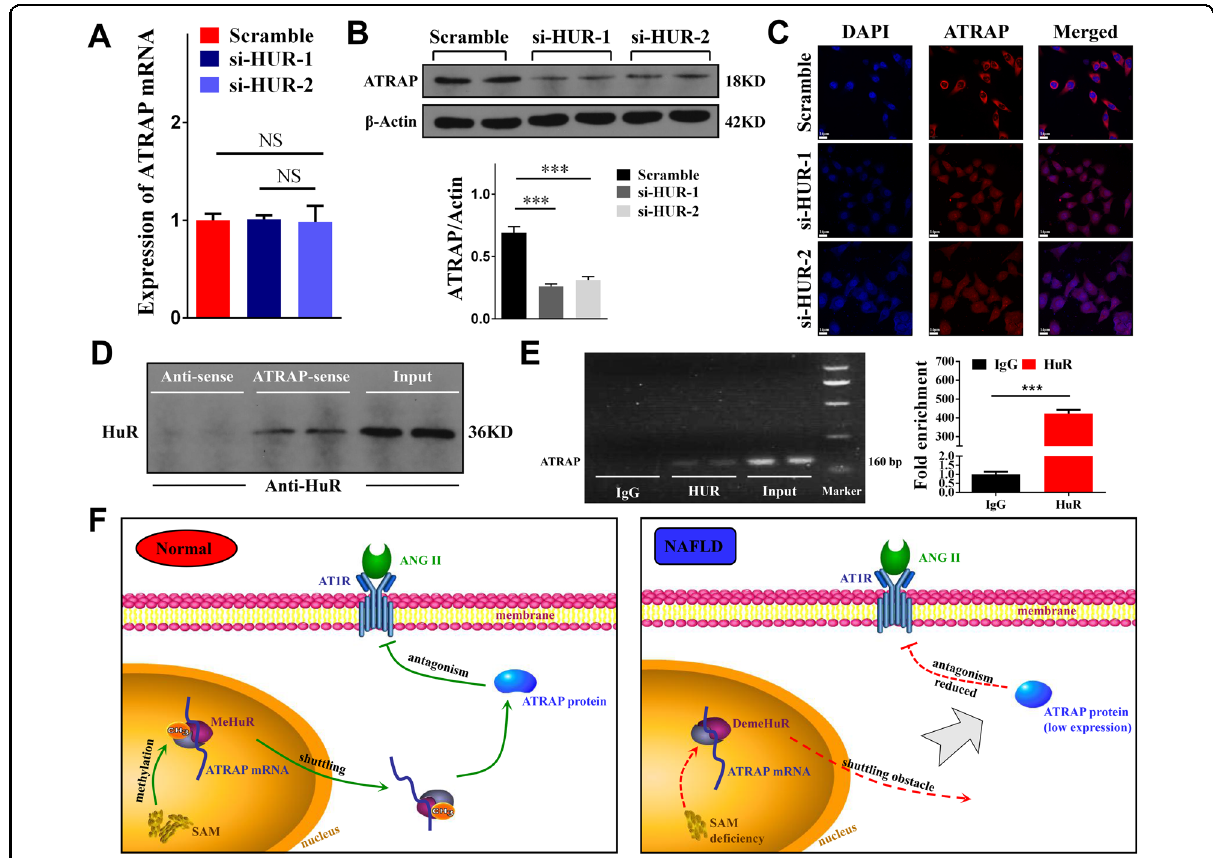
Fig. 5 HuR could directly bind ATRAP mRNA and regulate its nucleocytoplasmic shuttling. A Measurement of ATRAP mRNA levels by RT-PCR after transfection of L02 cells with HuR-siRNA. The error bars are the SDs ( n = 3). B The ATRAP protein level after HuR knockdown, as determined by western blotting. The error bars are the SDs ( n = 3). C FISH images showing ATRAP mRNA after HuR knockdown in L02 cells (bar = 14 μ m). D Western blot analysis of the speci fi c association of ATRAP mRNA with HuR in RNA pull-down assays. E RNA immunoprecipitation (RIP) experiments were performed using an HuR antibody, and speci fi c primers were used to detect ATRAP mRNA by qPCR. The error bars are the SDs ( n = 3). F Schematic of the proposed mechanism by which SAM upregulates ATRAP expression via HuR methylation to maintain ATRAP mRNA nucleocytoplasmic shuttling. NS not signi fi cant, *** P <